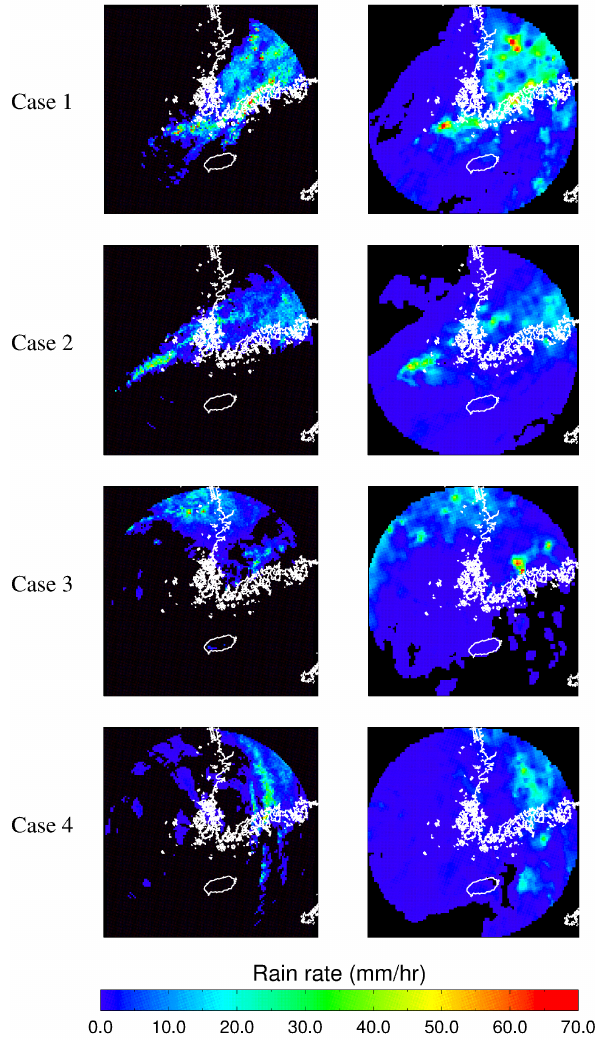
Figure 4. Images of the Jindo radar rain rates (left column) and satellite precipitation estimates after bias correction (right column) for the four precipitation cases.